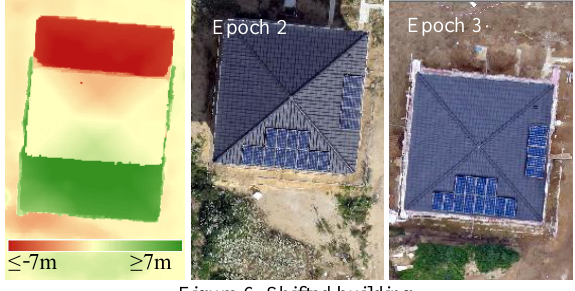
Figure 6: Shifted building